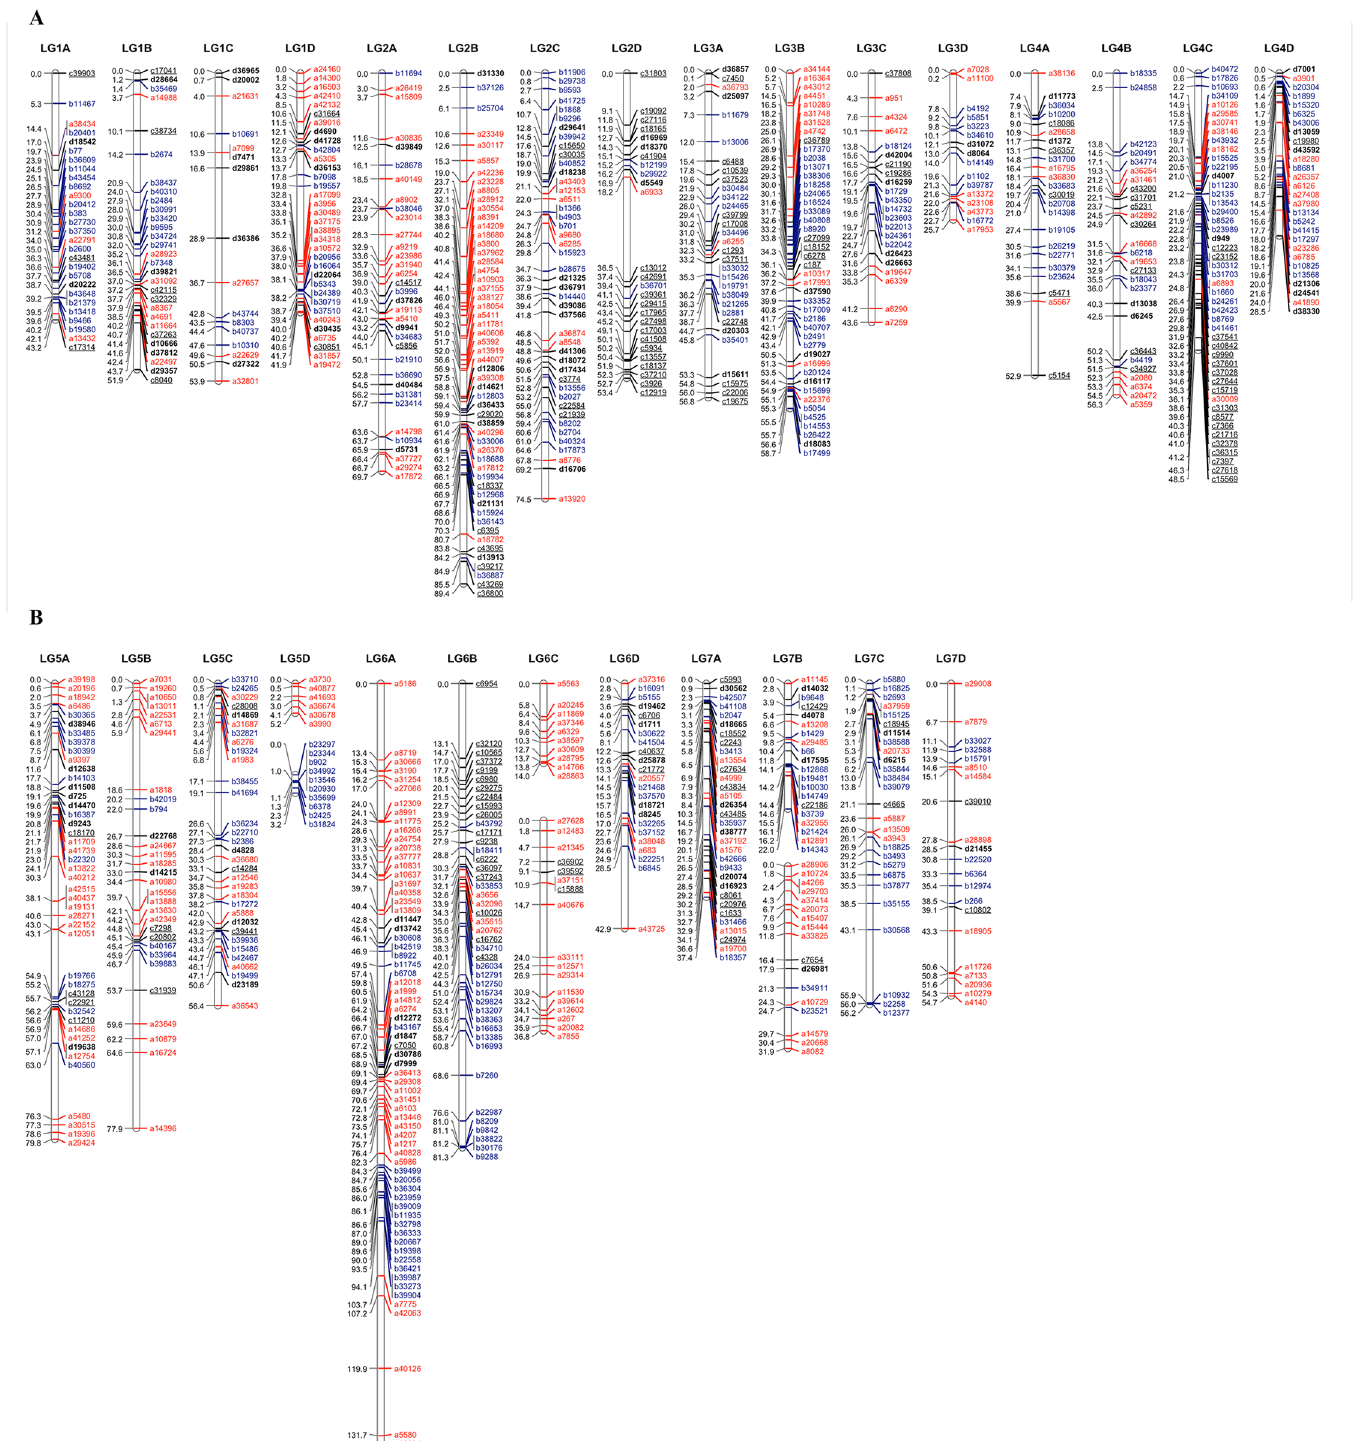
Fig 1. A SNP-based linkage map of a F . ×ananassa mapping population derived from the cross ‘ Sonata ’ × ‘ Babette ’ . Map distances are given in centi- Morgans (cM), marker colours indicate: Red – markers segregating in the ‘ Sonata ’ genetic background only; Blue – markers segregating in the ‘ Babette ’ genetic background only; Black – markers segregating in both genetic backgrounds (1:1:1:1 and 1:2:1 segregations are indicated with bold and underscore respectively).